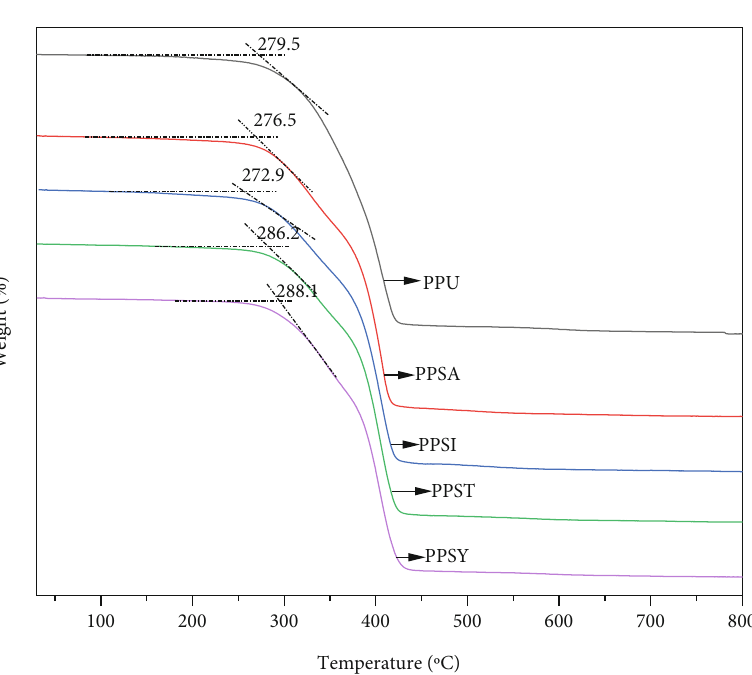
Figure 2: TGA curves of PPAs.